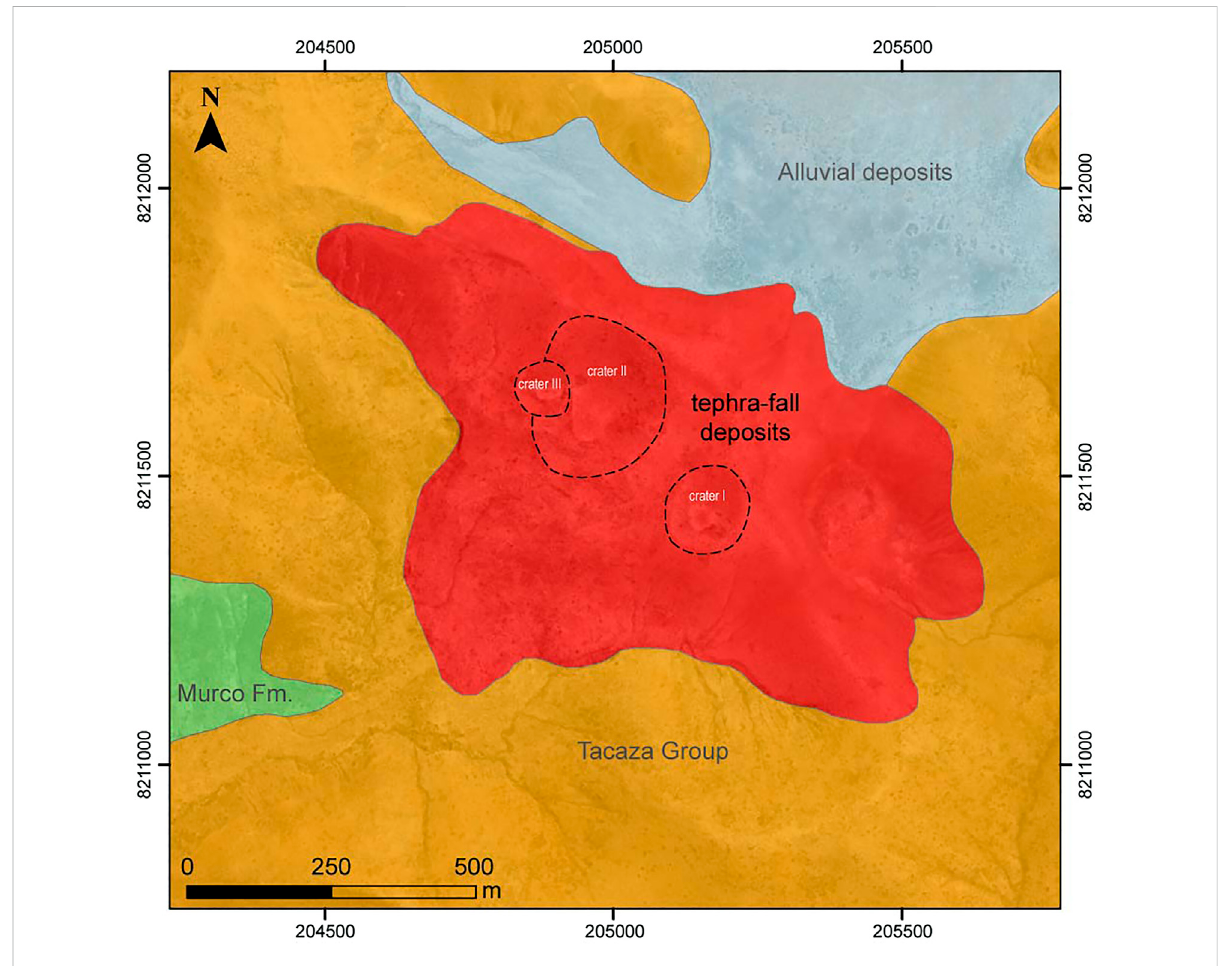
FIGURE 8 Geological map of Patacocha volcano, showing at least three identi fi ed